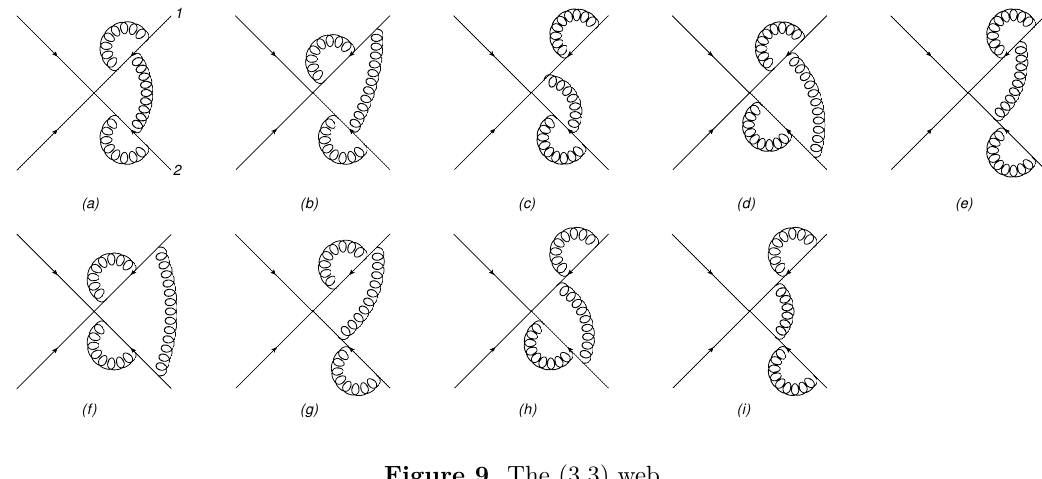
Figure 9 . The (3,3)